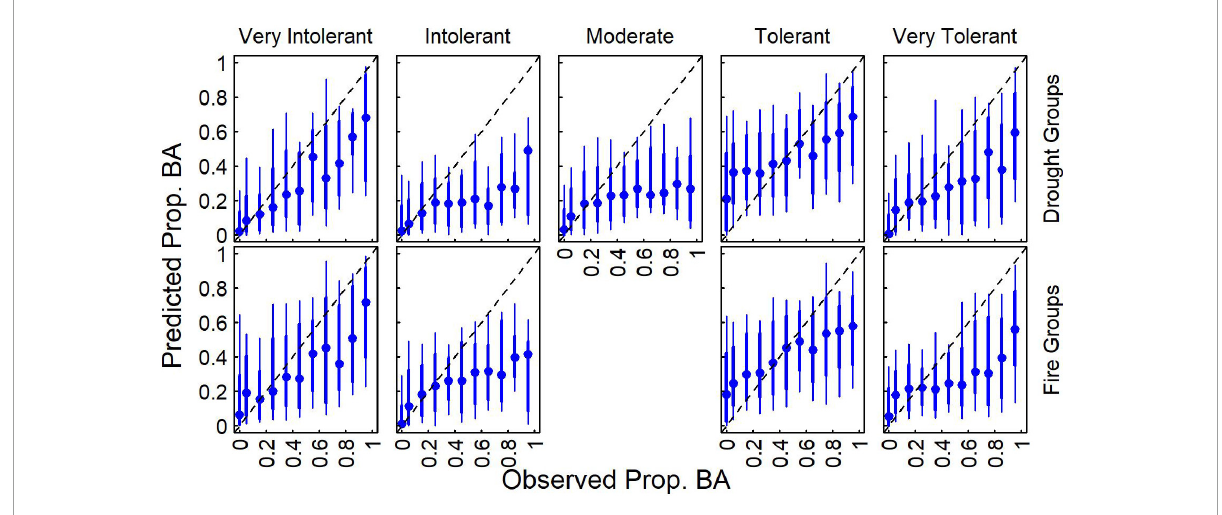
FIGURE4 Distribution of predicted proportional basal area compared to observed values for each of the five drought groups based on the community consensus model ( Table 2 ). Median (blue points), 16th to 84th percentile ranges (thick blue line), and 5th to 95th percentile ranges (thin blue line) predictions across observations are also